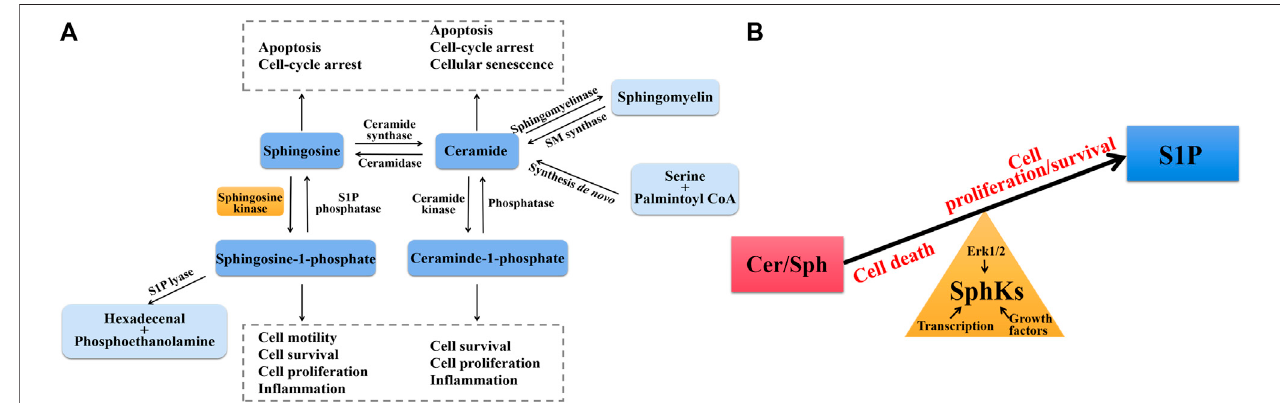
FIGURE1|(A) Sphingolipidbiosynthesisanddegradationpathways.Ceramide(Cer)isthecentralcoreofsphingolipidmetabolism,whichisgeneratedthroughthe denovo synthesispathway startingfromserineandpalmintoylCoA,theSMasepathway bydirectdegradation ofsphingomyelin(SM),andphosphorylationdegradation ofceraminde-1-phosphate(C1P).Undertheactionofceramidase, Cerisconverted intosphingosine(Sph),whichcanbefurtherphosphorylatedbySphKstoformS1P. S1P lyase catalyzes irreversible exit from this pathway. Cer and Sph induce cell cycle arrest and apoptosis, whereas C1P and S1P promote cell proliferation and growth and induce in fl ammation. (B) The balance of sphingolipid-rheostat. Interconversion between Cer/Sph and S1P via SphKs. Cer/Sph induced cell death, whereas S1P promoted cell proliferation and survival. Sphingolipid-rheostat is formed between Cer/Sph and S1P, which determines cell death or survival. SphKs has intrinsic catalytic activity that helps maintain normal physiological levels through the balance of sphingolipid-rheostat, and is also in fl uenced by Erk1/2, growth factors, and transcription